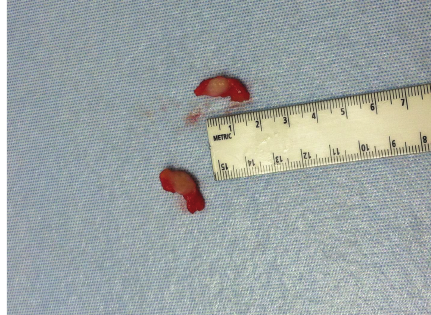
Figure 3: Excised, bivalved lesion revealing a white, smooth nodule measuring 1.3 × 0.6 × 0.3cm with surrounding